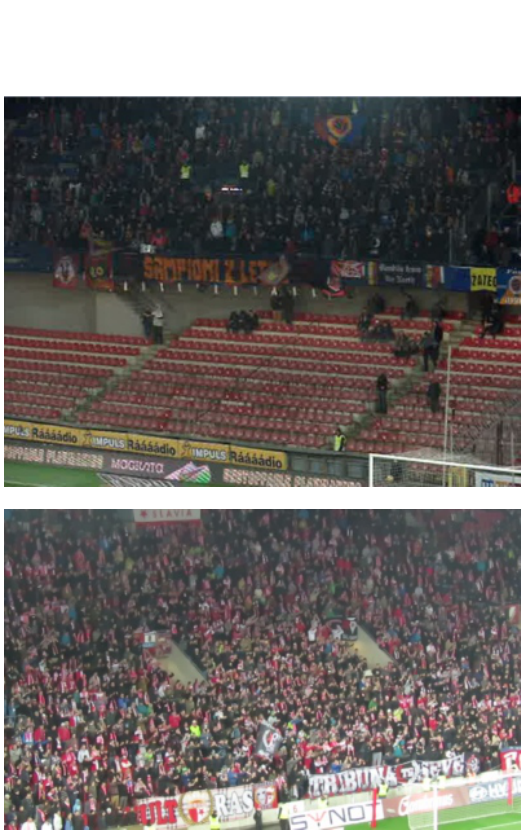
Figure 1. Photo of fans: Football stadium – Prague Letna(upper) [2], Football stadium – Prague, Eden (lower)